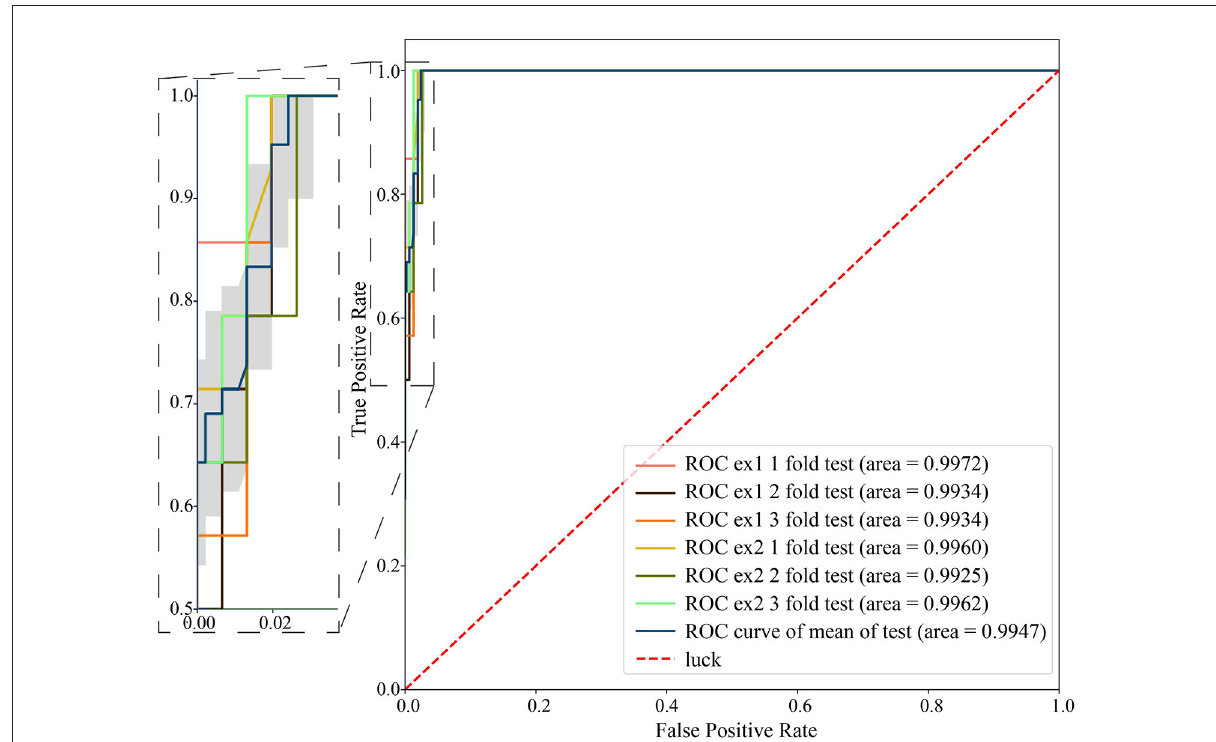
FIGURE9 The ROC curve and AUC values were obtained from 6-fold cross-validation using the RPKM threshold of HV08’s fingerprint. The classifier achieved a mean AUC value of 0.9947 on the validation